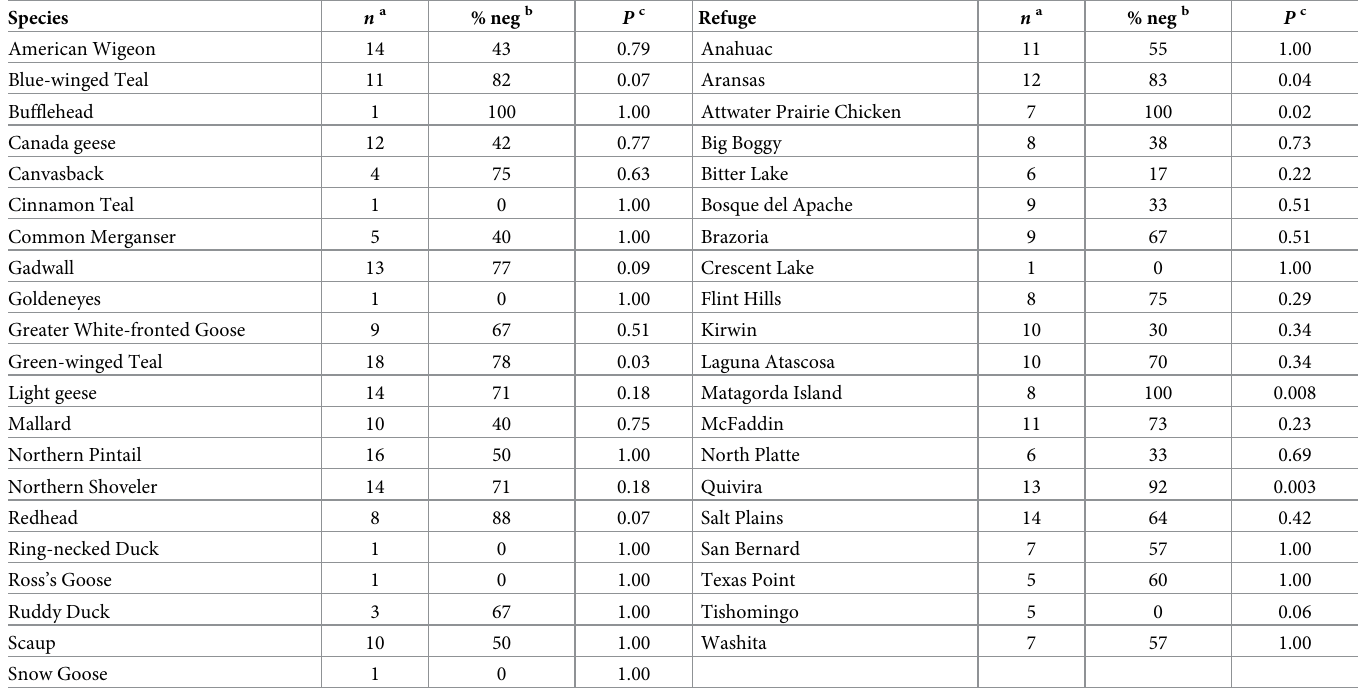
Table 1. Skewness in the distribution of slopes indicating advancements or delays in spring peak across years by waterfowl species and